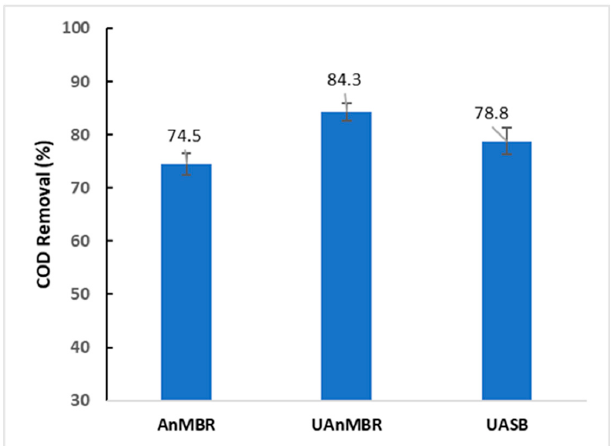
Figure 1. Chemical oxygen demand (COD) percentage removal efficacies monitored in the last two months of operation to access the steady ‐ state conditions of all the bioreactors. Sample were taken after every 5 days ( n = 12). The error bar represents standard deviation.